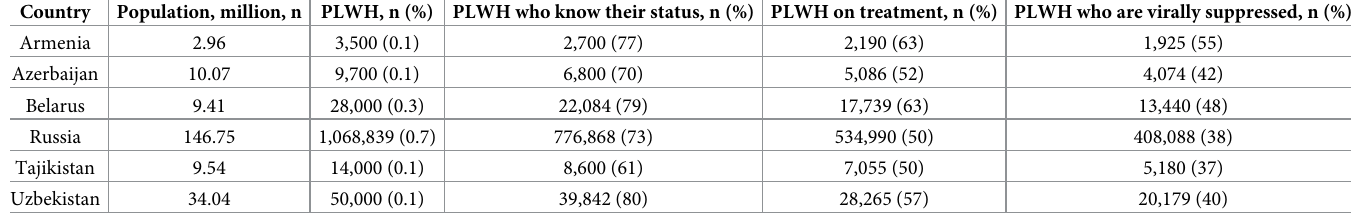
Table 1. HIV testing and treatment in the studied countries in